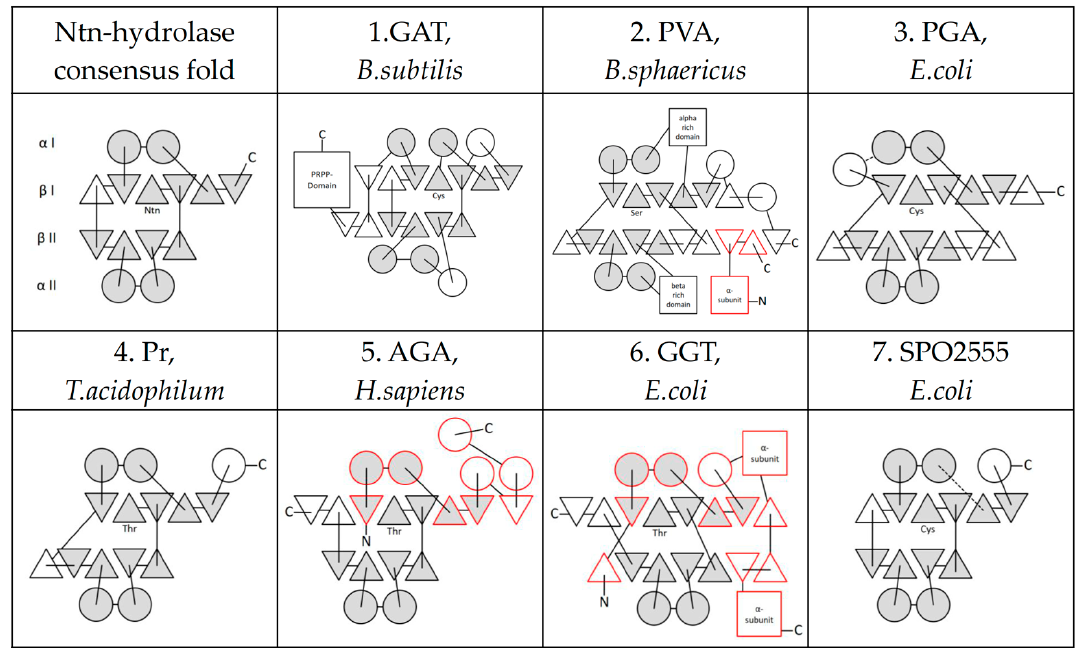
Figure 1. Secondary structural elements in Ntn-hydrolase subfamilies. The characteristic topology of αββα -secondary structure elements in N-terminal nucleophile (Ntn-)hydrolases consists of two α -helices (circles) in the α I-layer, five β -sheets (triangles) in the β I-layer, four β -sheets in the β II-layer, and two α -helices in the α II-layer (grey filling) [16]. Structurally, highly conserved elements between the various family members are filled in grey, while additional β -sheets (PVA) or α -helices (GAT) are white. The catalytic relevant Ntn residue is revealed at the newly generated N-terminus by autocatalytic cleavage in the β I-layer, either cleaving off only a few amino acids from the β -fragment (e.g., GAT, Pr) or forming a large α -subunit (red boxes) (e.g., AGA, GGT). The alpha subunit may even be a part of the highly conserved αββα -array. Dotted lines designate the presumed connections with diffuse electron density in the crystal structure. α -subunit elements are marked with a red frame, while β -subunit elements are marked with a black frame. Amino-termini (N), N-terminal nucleophiles (either Thr, Ser or Cys), and C-termini (C) are indicated.